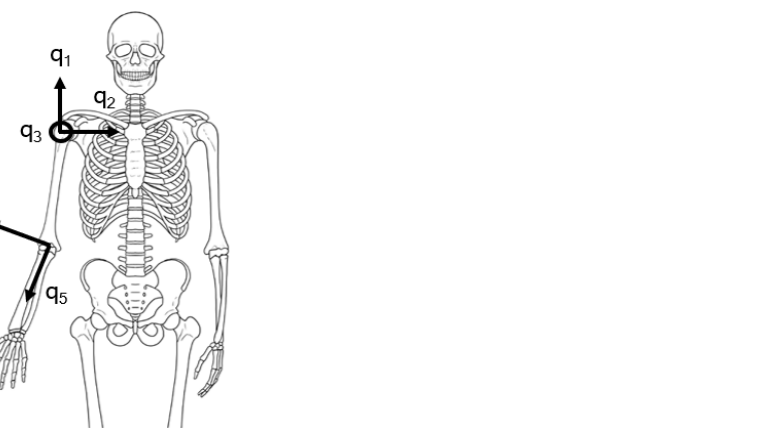
Figure 3. Kinematic model of the human arm (the angle q 3 is directed